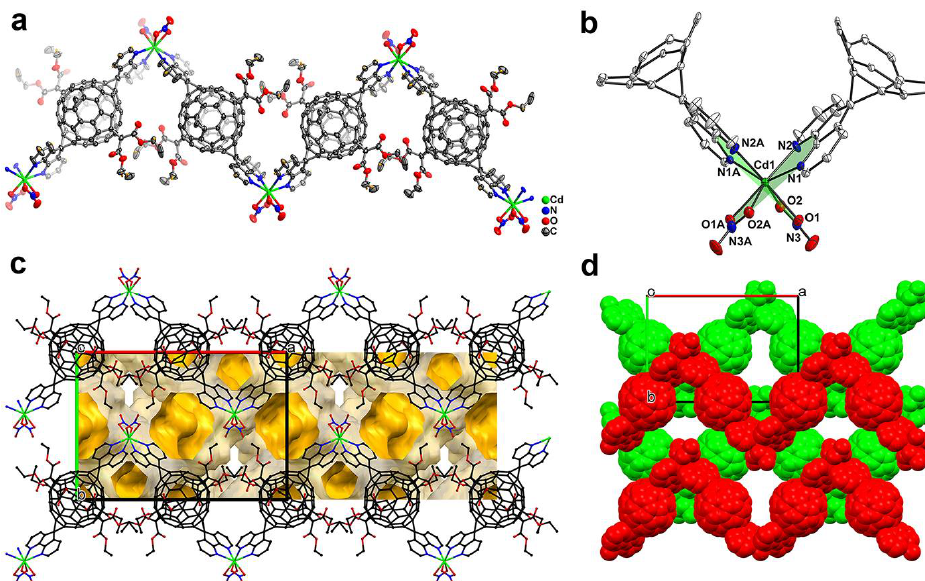
Figure 3. ( a ) The 1D infinite zigzag chain viewed down the c -axis in 2 with thermal ellipsoids shown at 50%, front and back malonate addends and all hydrogen atoms have been omitted for clarity; ( b ) the local environment of Cd1 in 2 ; ( c ) voids shown in bright yellow occupying approximately 43 % of 2 ; ( d ) interlayer relationship within the crystal lattice as seen down the c -axis. Hydrogen atoms and malonate addends have been omitted for clarity.